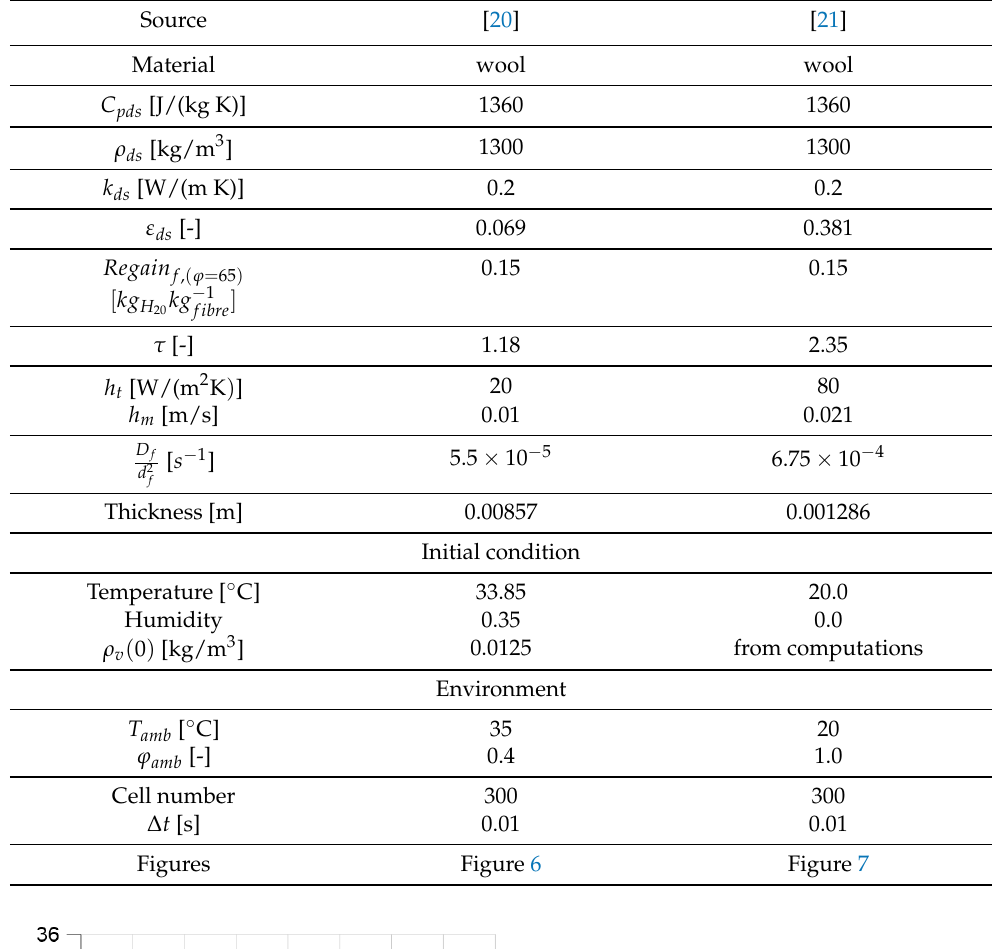
Table 2. Description of validation cases.